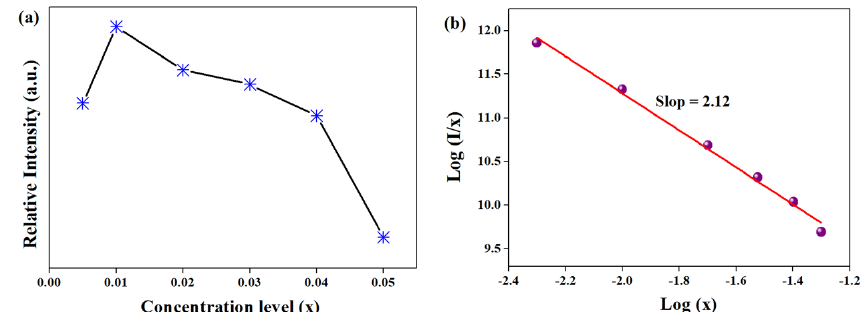
Figure 7. ( a ) The PL integrated intensities with Mn 4+ concentration, ( b ) as well as dependence of log(I/x) on log(x).